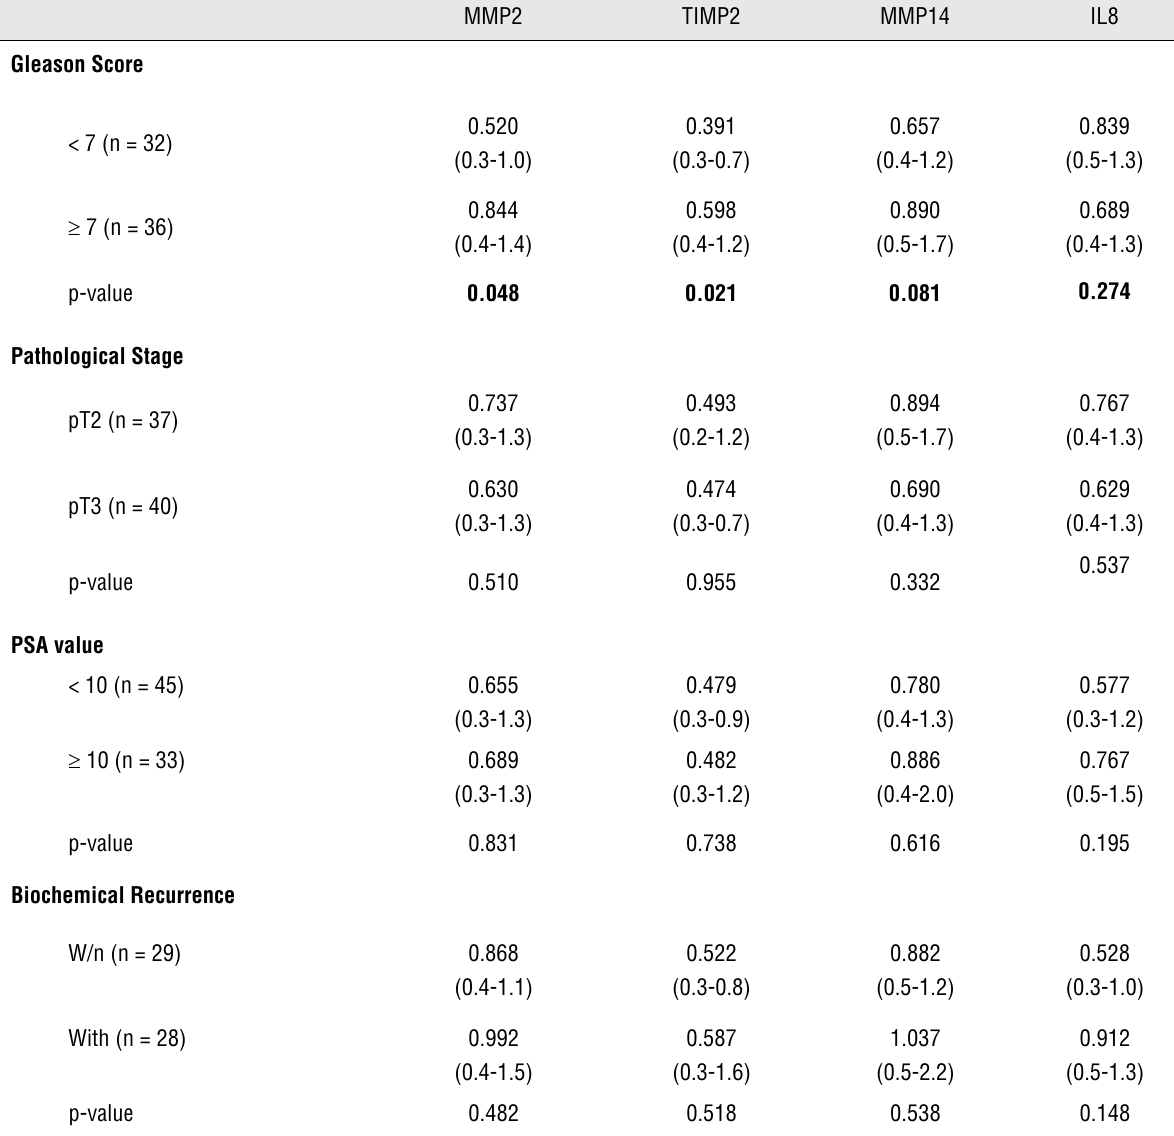
Table 3 - Relative expression of the four genes in malignant prostatic tissue according to Gleason scores, pathological stages, PSA values and biochemical recurrence. Fold changes in gene expression were calculated using the ∆∆ CT method (QRel = 2- ∆∆ CT